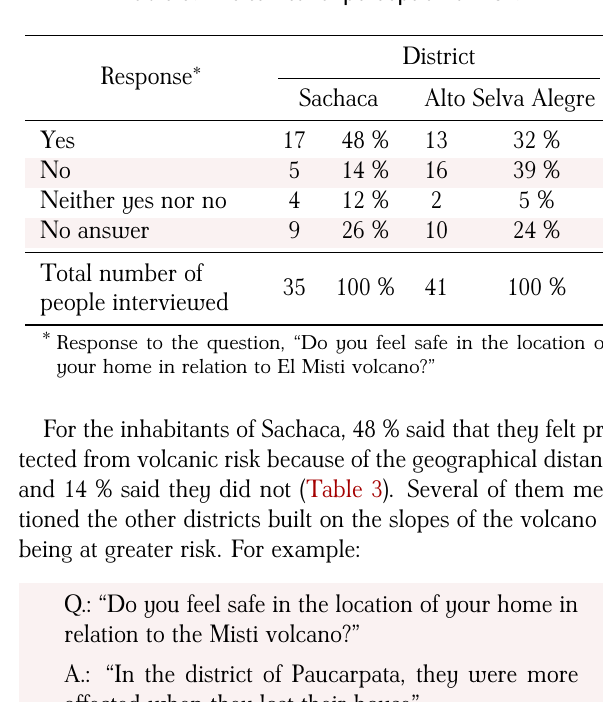
Table 3: The territorial perception of